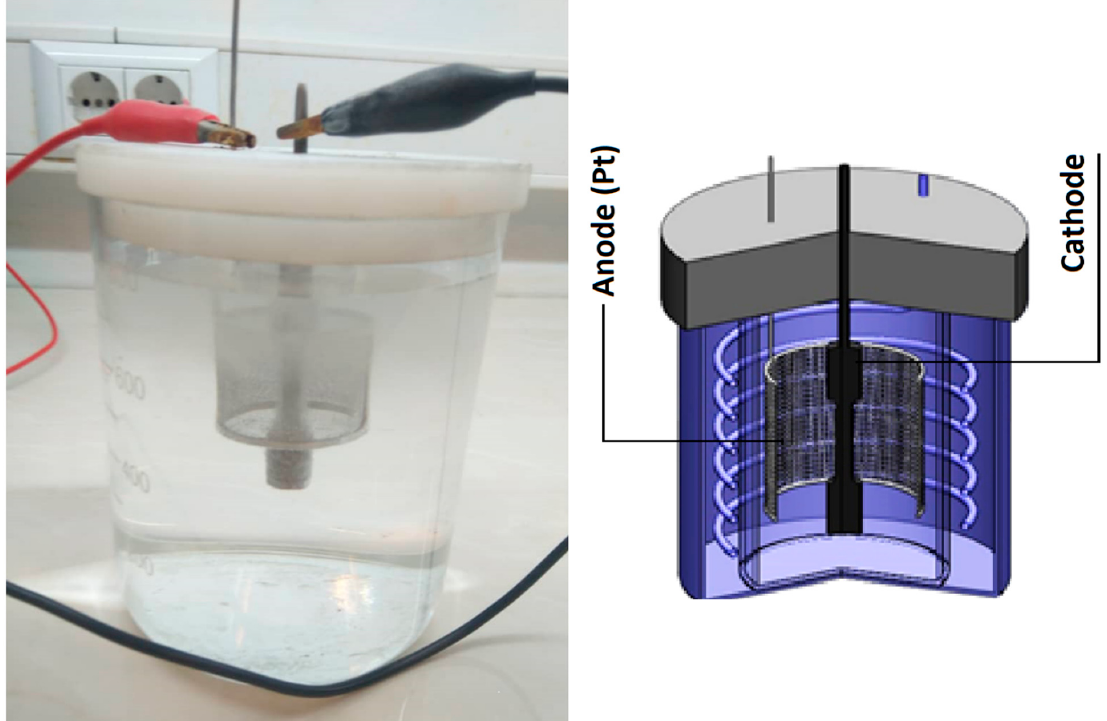
Figure 1. The electrochemical process for hydrogen charging of L-PBFed samples. After the tensile test, the microstructures of the samples and fractured surfaces were investigated using an optical microscope (OM) (3d imaging: OPTIKA B-383MET-Pon- teranica, Italy) and an scanning electron microscope (SEM) (MIRA3 TESCAN, Czech Re- public, SEM HV: 15.0 kV, window Type: Moxtek AP1.3). For this aim, the samples were mechanically ground with fine SiC papers (grit number up to 2000) and subsequently pol- ished with 3 μ m diamond suspension and finally with 0.05 μ m silica suspension. Finally, to confirm the austenite stability, XRD analysis was performed using an Explorer (GNR- Analytical Instruments Group, Italy, CuK α , λ = 1.5406 Å, 40 kV, 30 mA, and step size 0.01). 3. Results Figure 2 shows the microstructure of the L-PBFed 316 L before the hydrogen charg- ing. It is worth noting that the laser scanning direction was rotated by 67° after each layer, leading to differently oriented melt pools, as depicted. Many grains include melt pool boundaries (MPBs), suggesting the epitaxial growth of new grains from re-melted zones [31]. The presence of MPBs and such epitaxial growth, which forms a texture, is among the specific characteristics of the L-PBFed materials that can directly affect their mechani- cal properties along different axes.